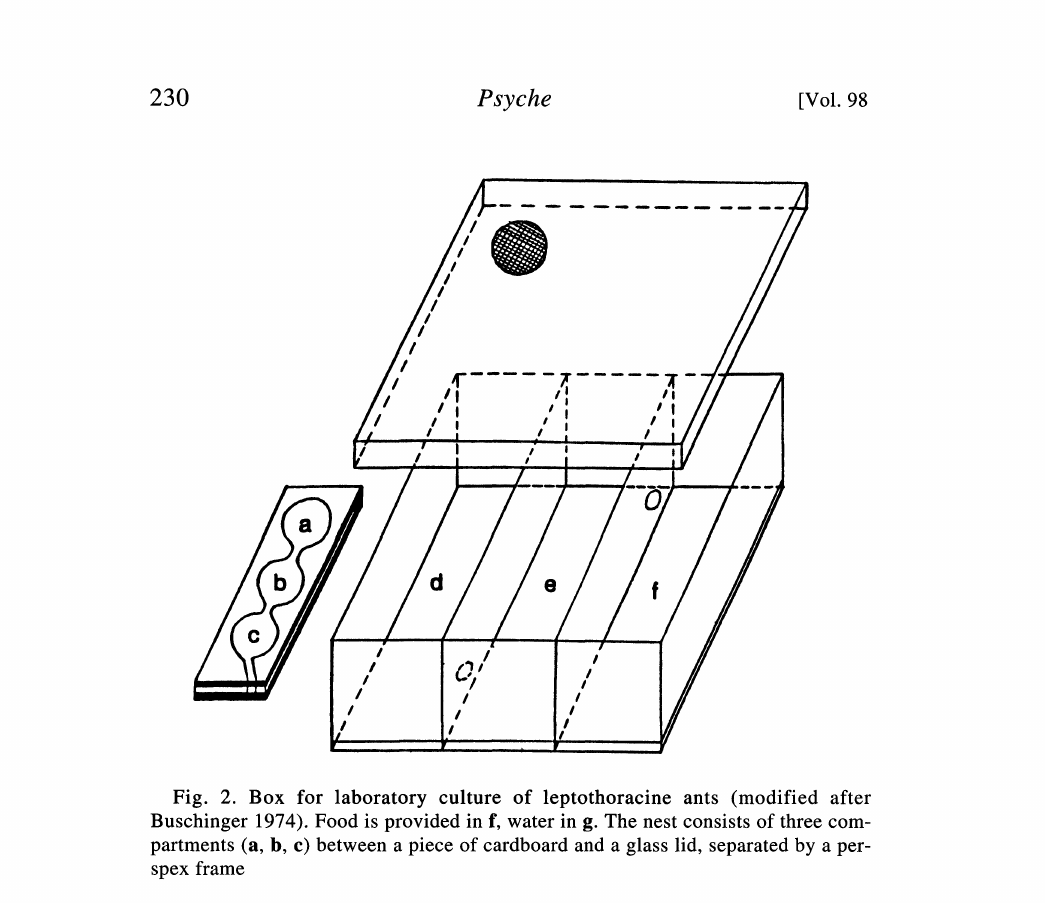
Fig. 2. Box for laboratory culture of leptothoracine ants (modified after Buschinger 1974). Food is provided in f, water in g. The nest consists of three com- partments (a, b, c) between a piece of cardboard and a glass lid, separated by a per- spex